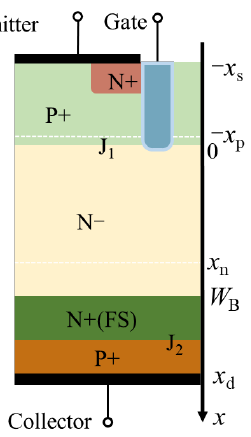
Figure 2. Structure of field-stop IGBT chip.